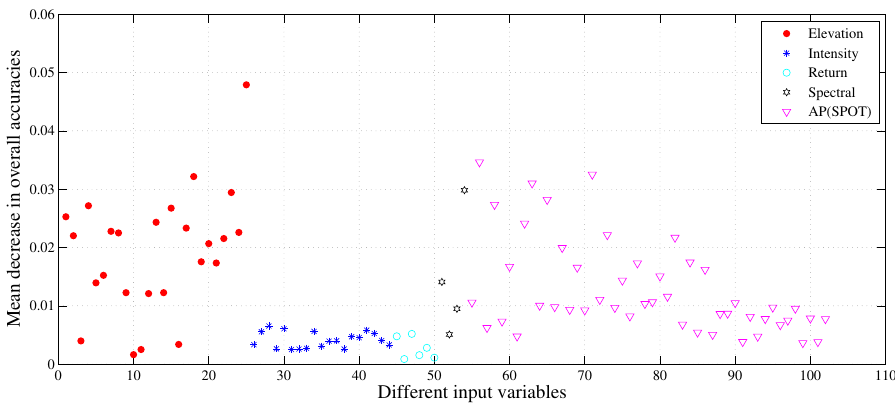
Figure 4. Importance of the 102 input features provided by SPOT-5 and LiDAR data.